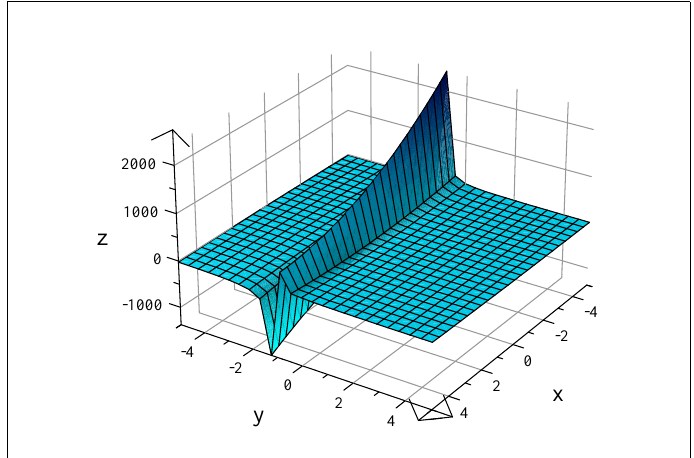
Figure 1. Surface Plot of F 1,3;2 ( x , y )